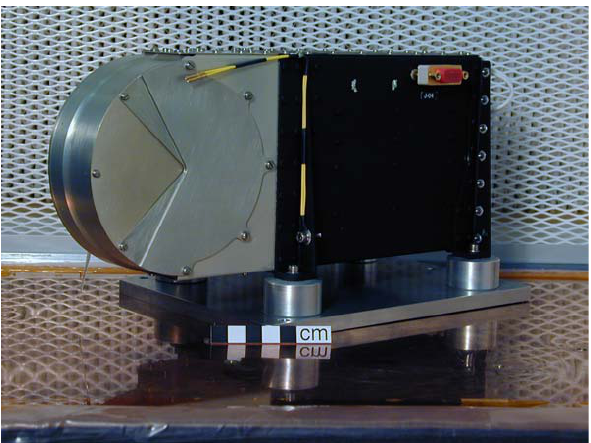
Fig. 6. TC-1 PEACE DPU and Sensor together with the radiation Figure 6. TC-1 PEACE DPU and Sensor together with the radiation shields for the shields for the electronic electronic sub-systems. Fig. 5. A view of the TC-1 PEACE Sensor. Note the analyser head Figure 5. A view of the TC-1 PEACE Sensor. Note the analyser head radiation shield radiation shield material intended to protect the MCP, in particular material intended to protect the MCP, in particular the pie-slice plates and the enhanced the pie-slice plates and the enhanced thickness rim of the cylinder thickness rim of the cylinder towards the aperture side of the sensor head. towards the aperture side of the sensor head.